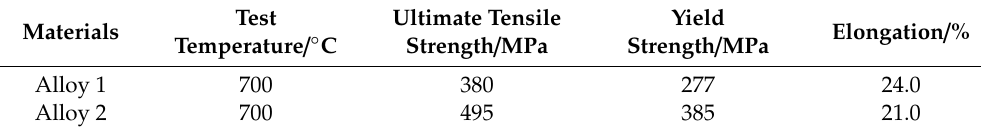
Table 8. High-temperature tensile test properties of two